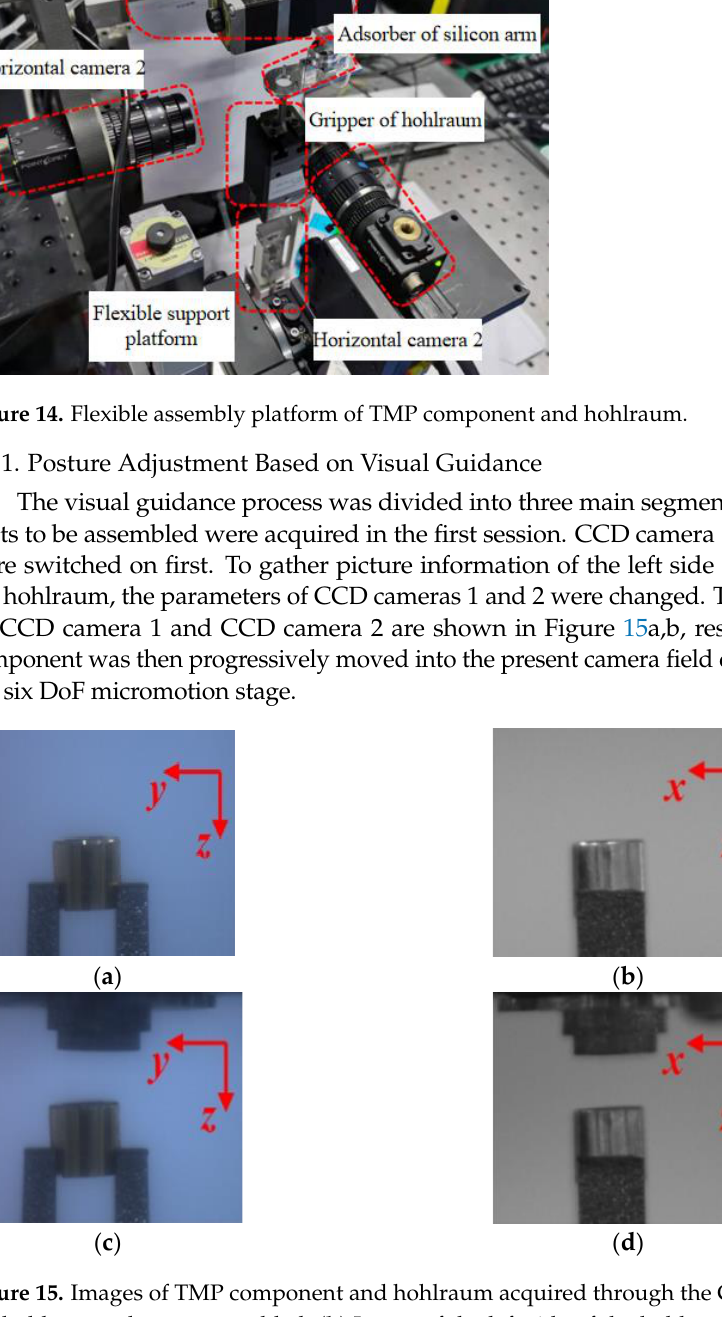
Figure 15. Images of TMP component and hohlraum acquired through the CCD. ( a ) Front view of the hohlraum when unassembled; ( b ) Image of the left side of the hohlraum when unassembled; ( c ) Front view of the sleeve after it enters the assembly area; ( d ) Image of the left side of the sleeve after it enters the assembly area. Image calibration was done in the second session. The reference object was chosen first in the calibration process. The hohlraum in the CCD camera 1 picture and the hohlraum in the CCD camera 2 images were then calibrated by drawing lines to ascertain the correspondence between the images and the real component size, respectively. The diameter of the outer ring of the hohlraum was utilized as the reference size in this